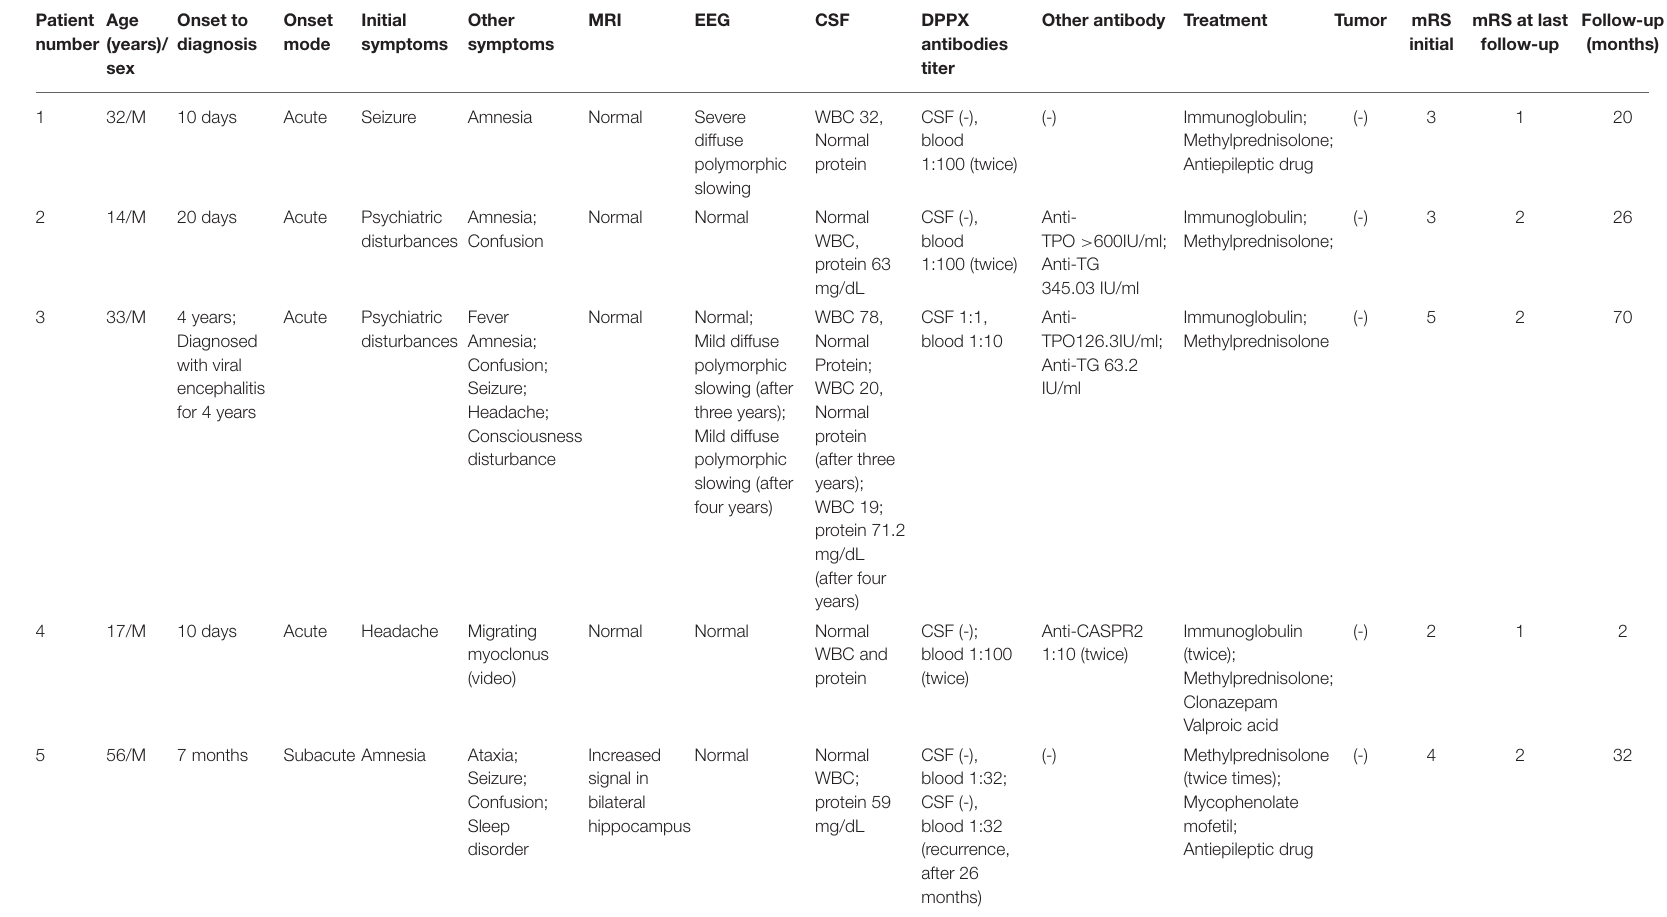
TABLE 1 | Clinical presentation in patients with anti-DPPX encephalitis. Patient Age number